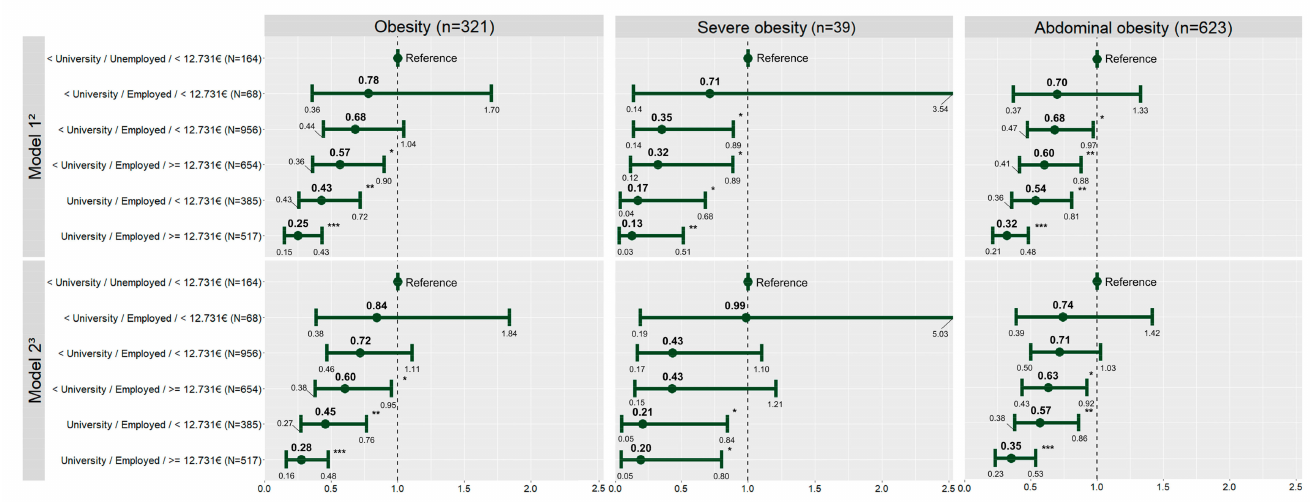
Figure 2. Association between composite socioeconomic status and general, severe, and abdominal obesity ( n = 2791)—PASOS study. Spain, 2019–2020. 1 1 Performed by logistic regression analysis. 2 Model 1: Adjusted for gender and age. 3 Model 2: Adjusted for gender, age, school, adherence to the Mediterranean diet, and minutes of MVPA. * p < 0.05; ** p < 0.01; *** p <